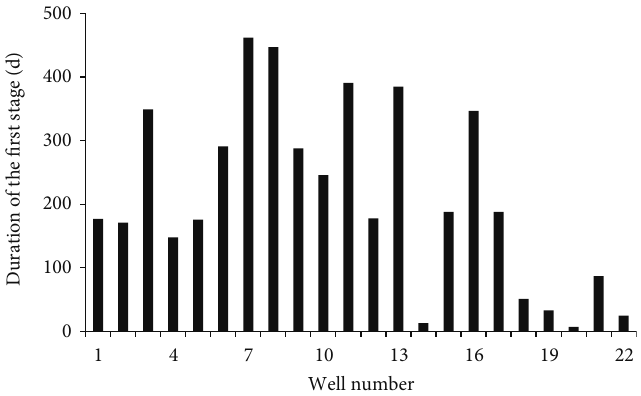
Figure 2: Initial dewatering stage duration of DCBM wells in